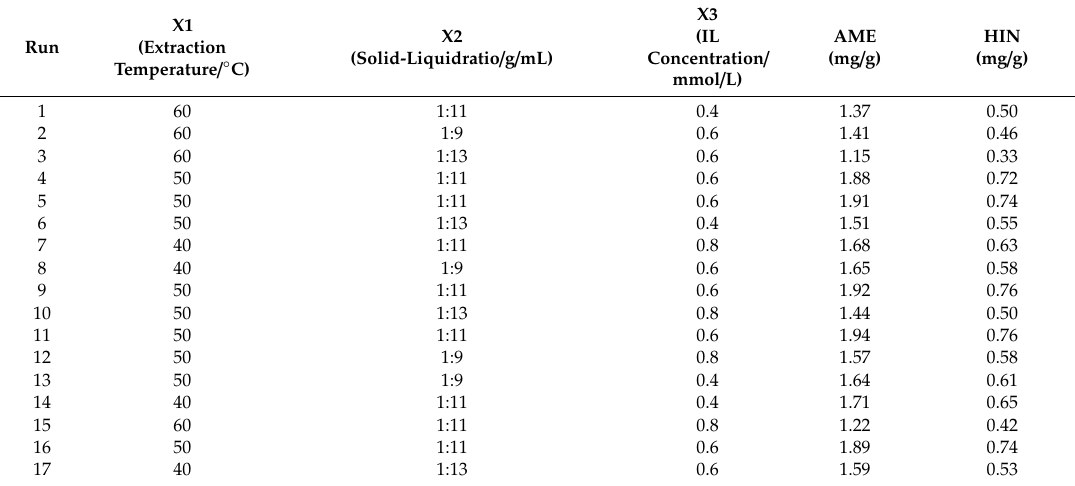
Table 7. The results of experiment